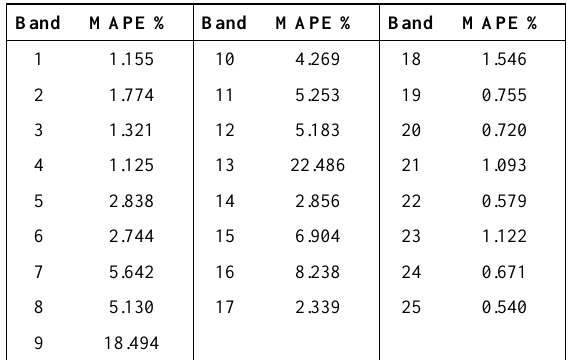
Table 3. MAPE% obtained from the radiometric resolution reduction to 8